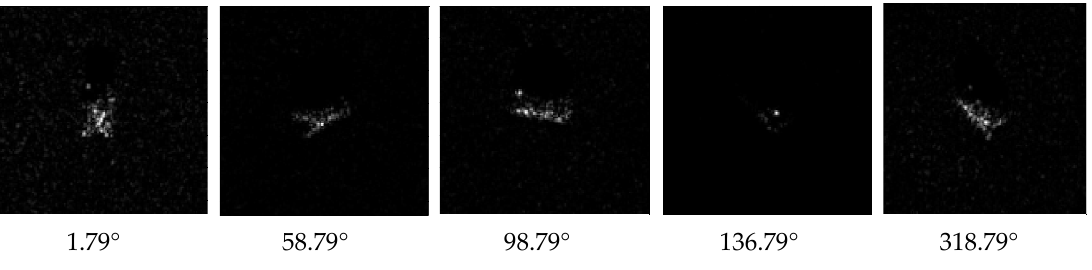
Figure 2. Microwave images of BMP2 at different aspect angles (depression angle 17°).